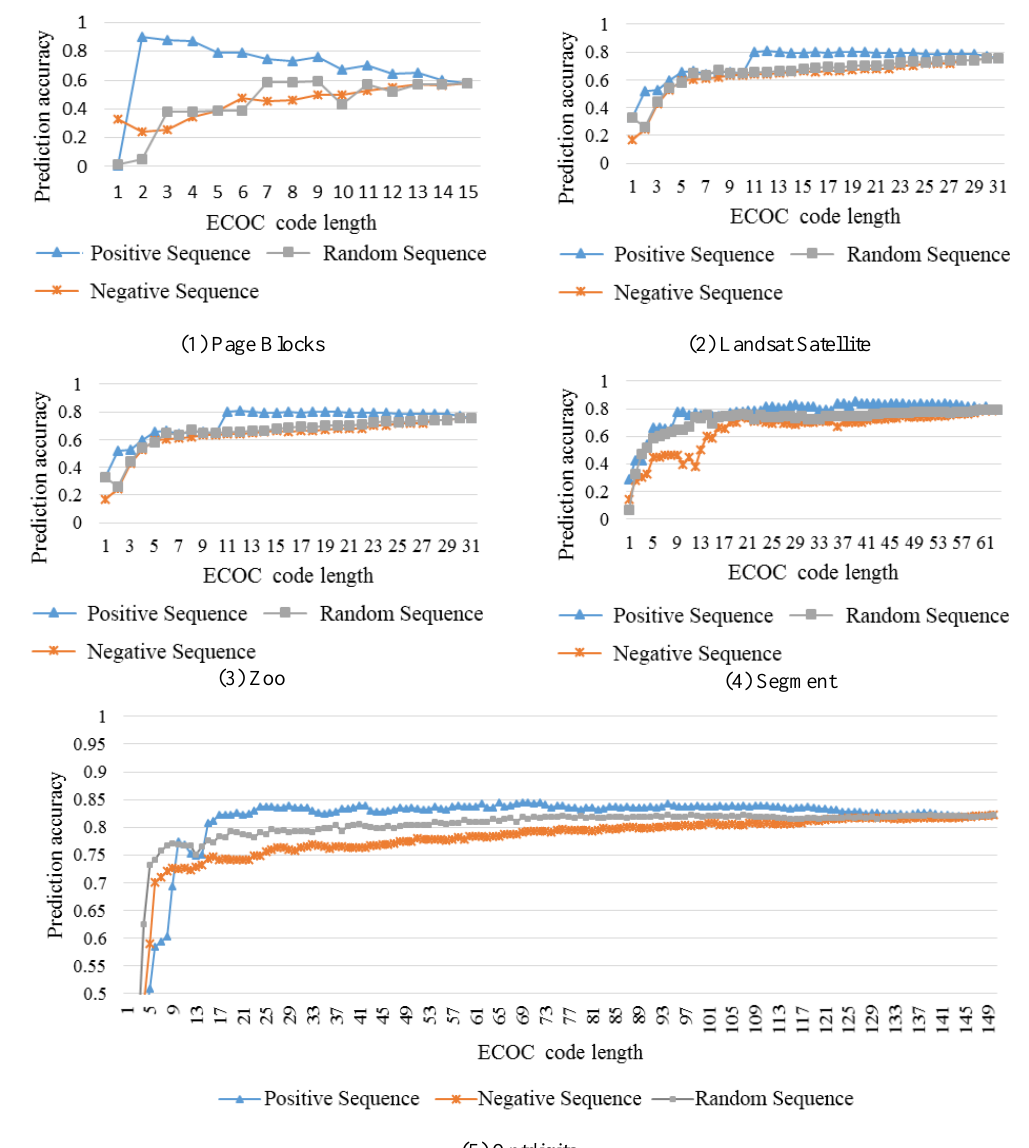
Figure 2. the prediction accuracies according to the different sorting sequences of sub -classifiers